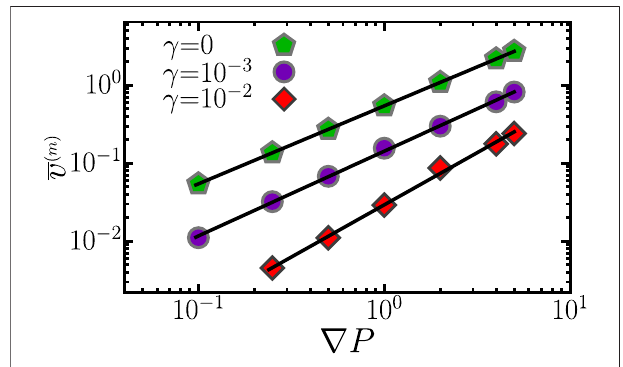
FIGURE 4 | Temporal average velocity of the mixture in the stationary regime as a function of the pressure gradient, for different values of surface tension. Each point on the graph correspond to a speci fi c capillary number. For better visibility, the curves for different values of γ were shifted vertically by one order of magnitude with respect to each other. The velocity can be described as a generalized Darcy ’ s law, (cid:1) v ( m ) ∝ ( ∇ P ) β , where the exponent increases with the surface tension. Green markers present the traditionalDarcy ’ slawwith β =0.99±0.01,obtainedfor γ =0and M =1,while β = 1.09 ± 0.02, for γ = 10 − 3 N/m, and β = 1.34 ± 0.03, for γ = 10 − 2 N/m. The cases where drops are permanently trapped in the pore matrix arenot plotted in the